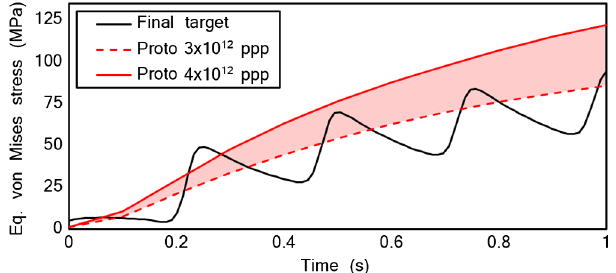
FIG. 9. Von Mises equivalent stress evolution at the point of maximum stress of the Ta2.5W cladding (block 4) during the beam impact of 1 second. Comparison between the final target and the target prototype at two different intensities. For the final target, the effect of the beam dilution in four circular turns can be clearly observed.